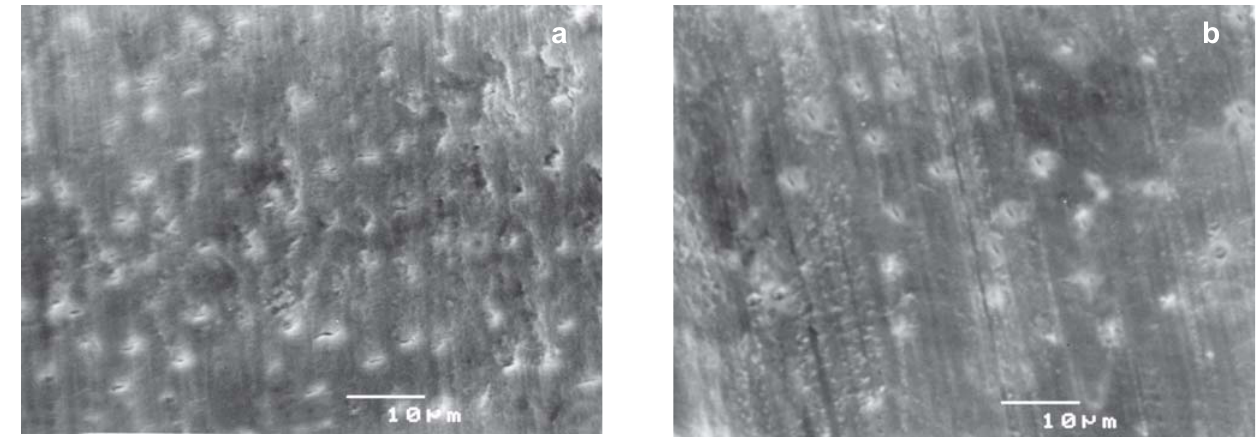
FIGURE 5- Dentin surface cut by: a) carbide bur after conditioning with Vitremer primer; b) diamond bur after conditioning with Vitremer primer (Original magnification 1500X, bar=10